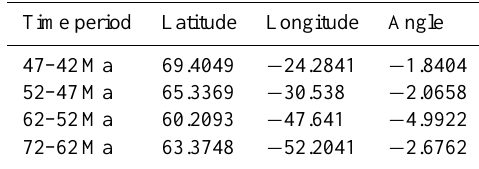
Table 2. Stage rotations for absolute Pacific plate motion from the geodynamic model.